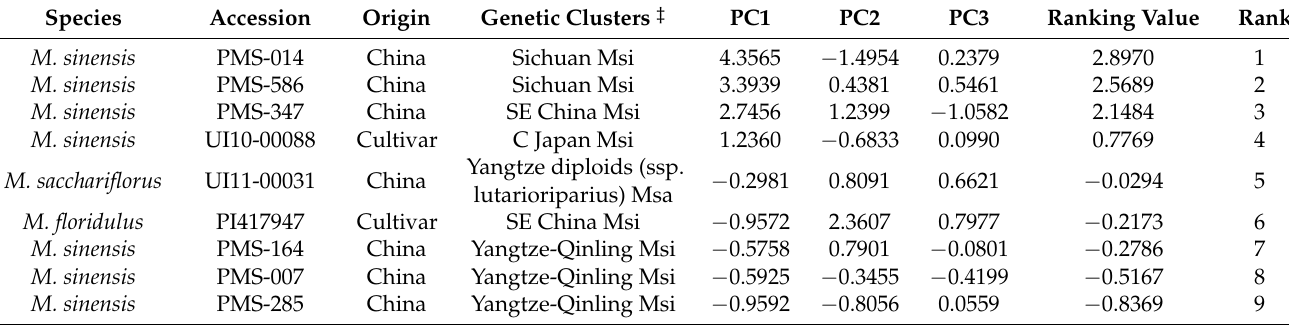
Table 7. Recovery principal components analysis (PCA) ranking values † based on the recovery drought stress index and the rank of recovery capacity from drought stress of fourteen Miscanthus genotypes in post-drought recovery experiment at Brigham Young University, Provo, Utah,